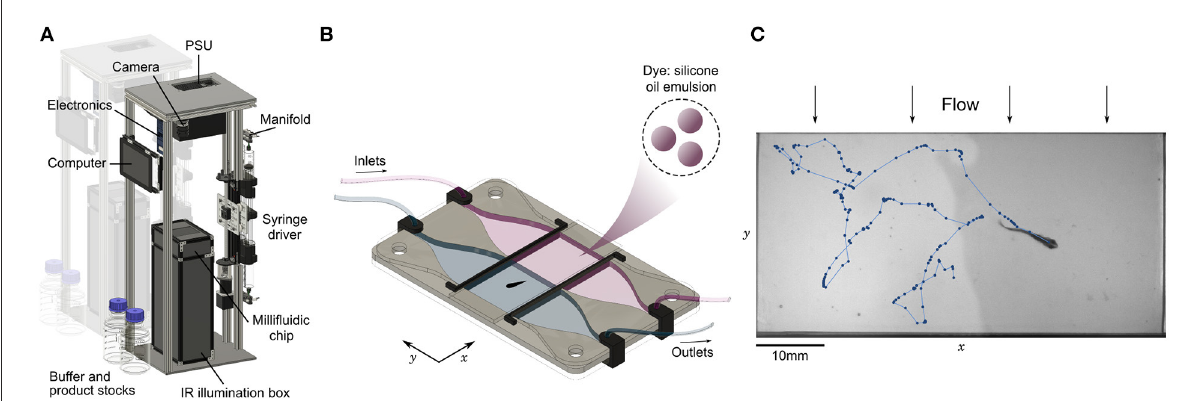
FIGURE1 Automated assay for preference in fish. (A) Annotated view of the rig. The vertical structure has a low table-top footprint, allowing to align multiple setups side-by-side. (B) Schematic view of the millifluidic chamber during dual infusion of buffer (water) on one side, and a mixture of a water-soluble compound and a diluted emulsion of silicone oil droplets used as a dye on the other side, creating an interface at the center of the imaging chamber. (C) Sample image and trajectory over 25s of a juvenile zebrafish (28 dpf) swimming in the chamber. Due to the mild transverse flow, the interface continuously regenerates in less than 10